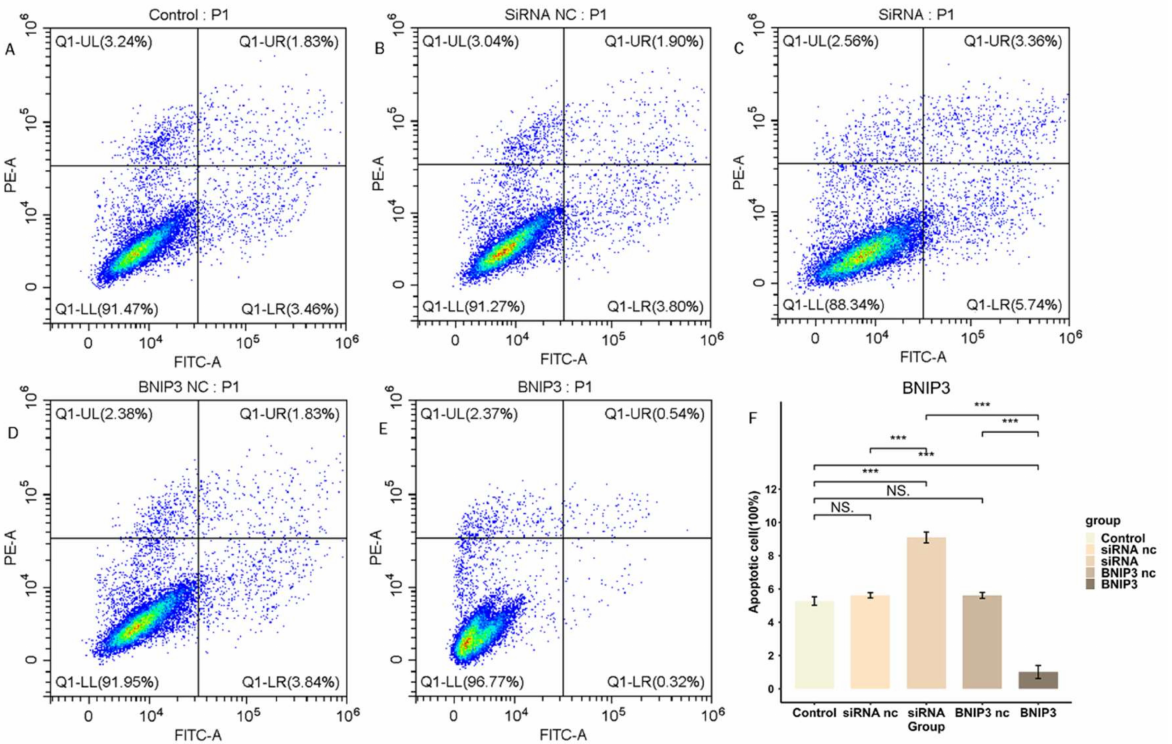
Figure 16. BNIP3 regulates the apoptosis of osteosarcoma cells. ( A – E ) Apoptosis of osteosarcoma cells after knockdown or overexpression of BNIP3. ( F ) Overexpression of BNIP3 inhibits apoptosis of osteosarcoma cells, while knockdown of BNIP3 promotes apoptosis of osteosarcoma cells. “NS” represented “No significant difference”, “***” represented “ p <